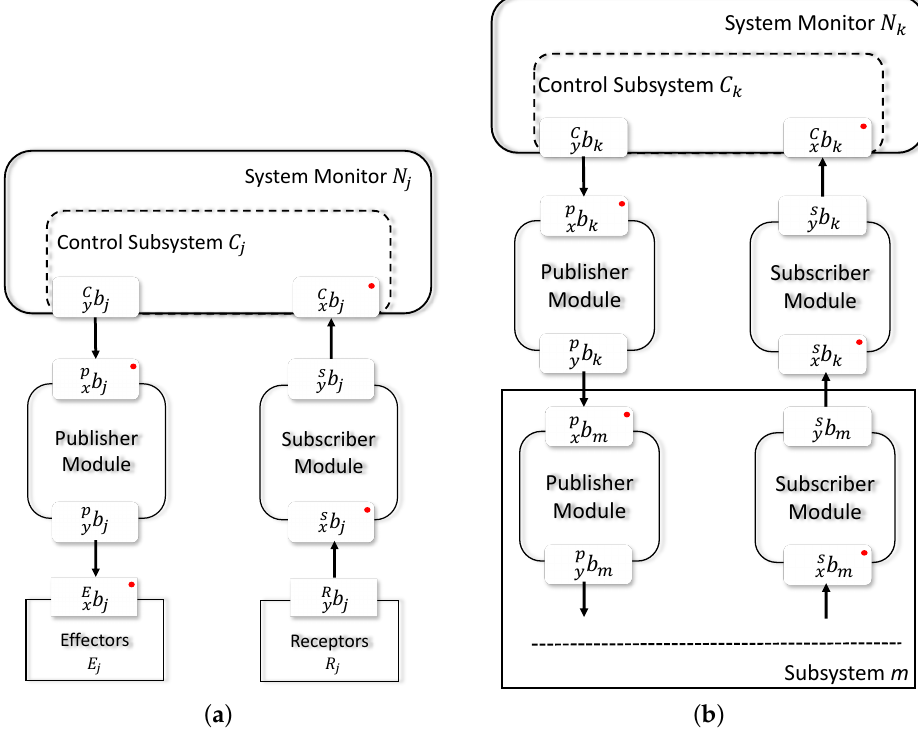
Figure 4. Diagram of control subsystem module communicated with effectors and receptors ( a ); communicated only with other module ( b ). The idea is adopted from